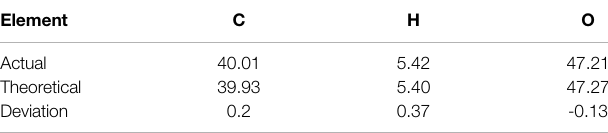
TABLE 3 | Elemental analysis for nano fi bers based on cyclodextrin and egg shell waste.